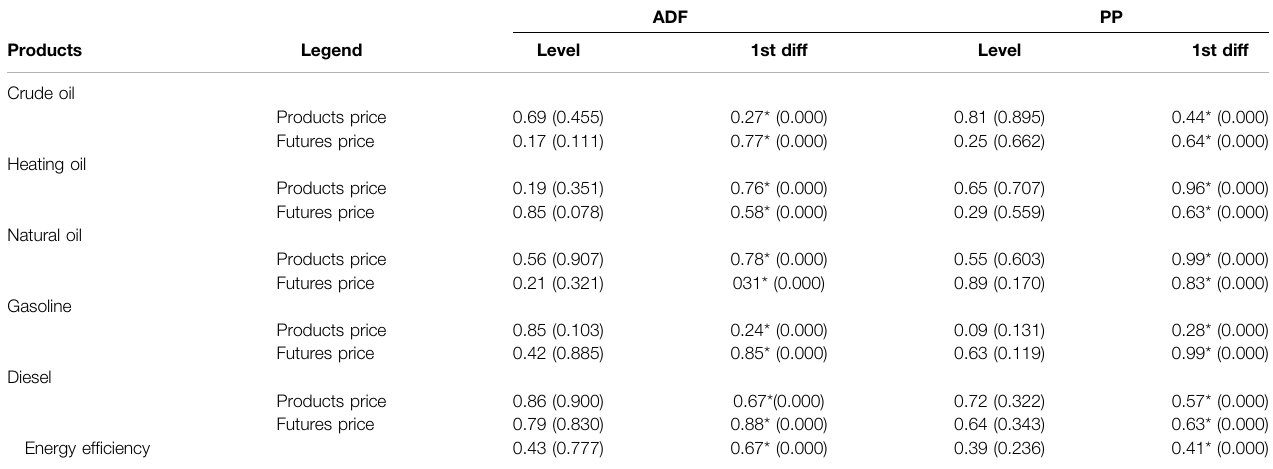
TABLE 3 | Unit root analysis.